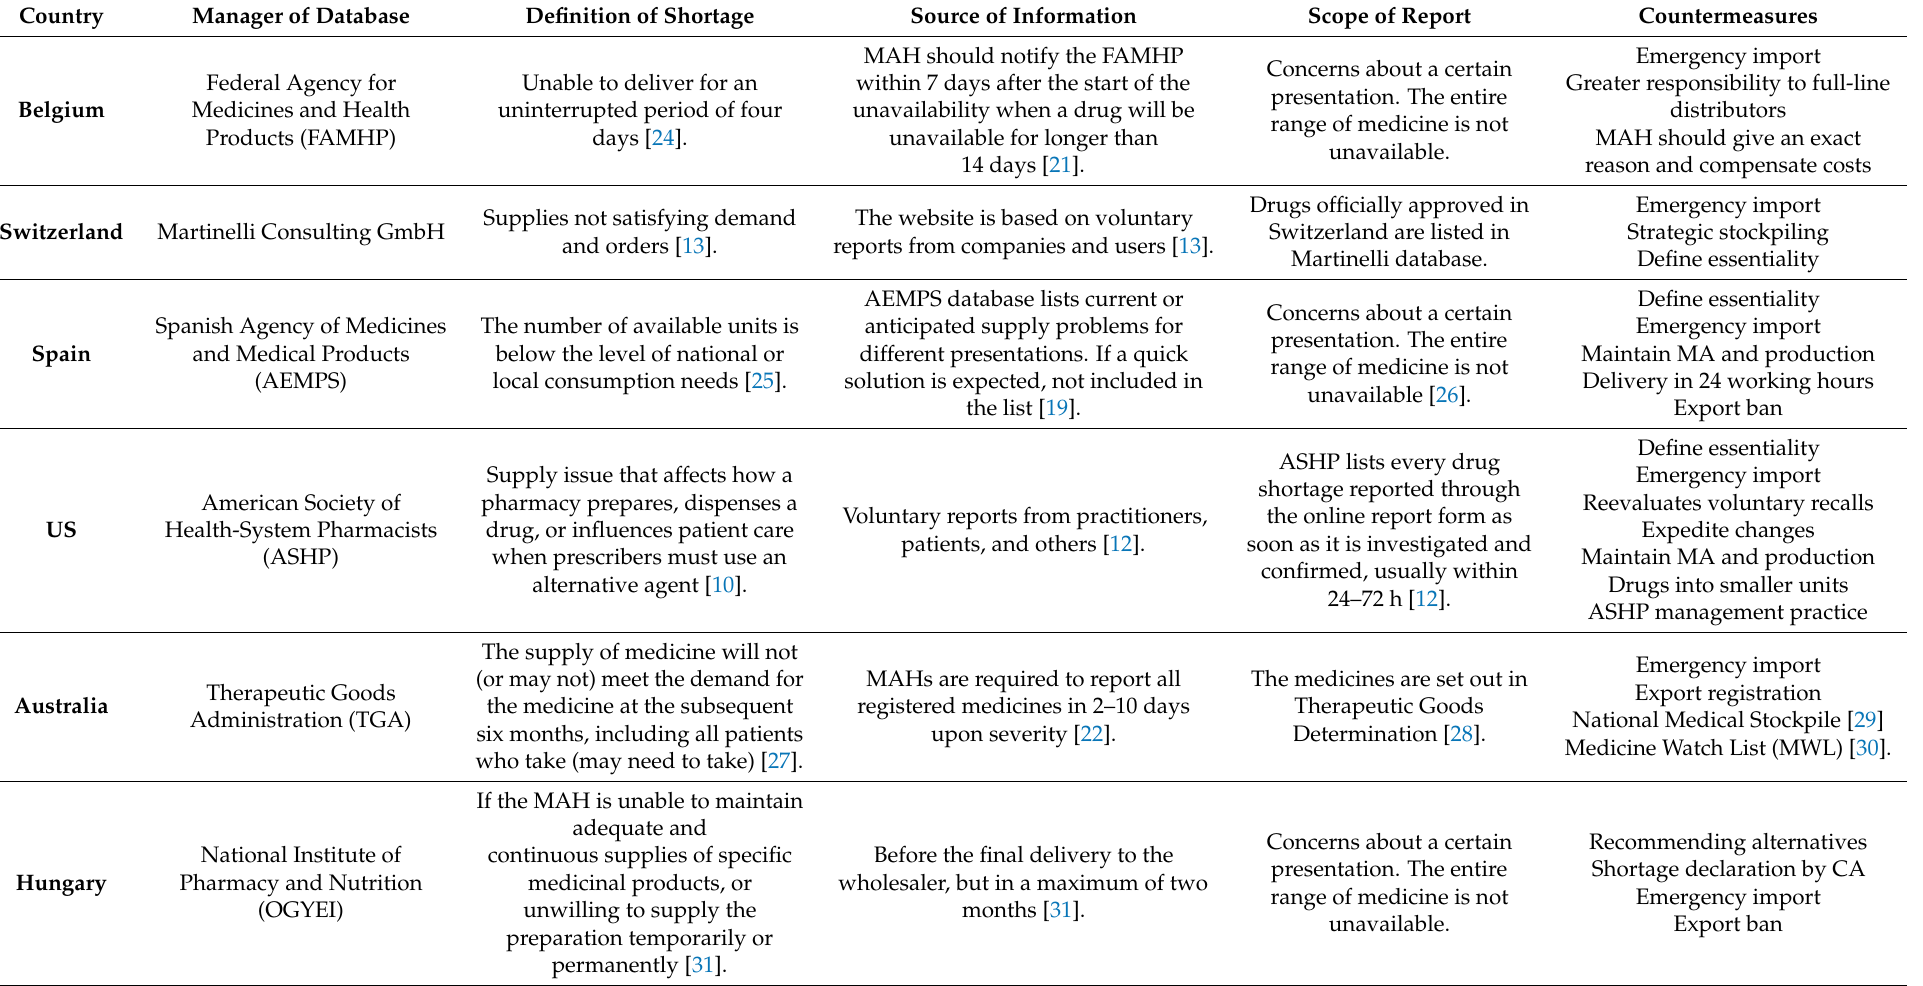
Table 2. Characteristics of notification